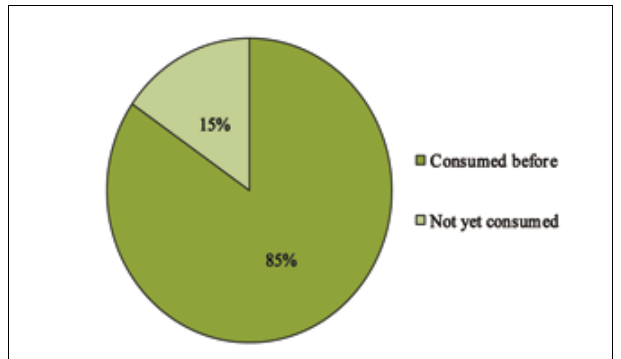
Figure 6. Asparagus consumption by elder generation (over 30 years)